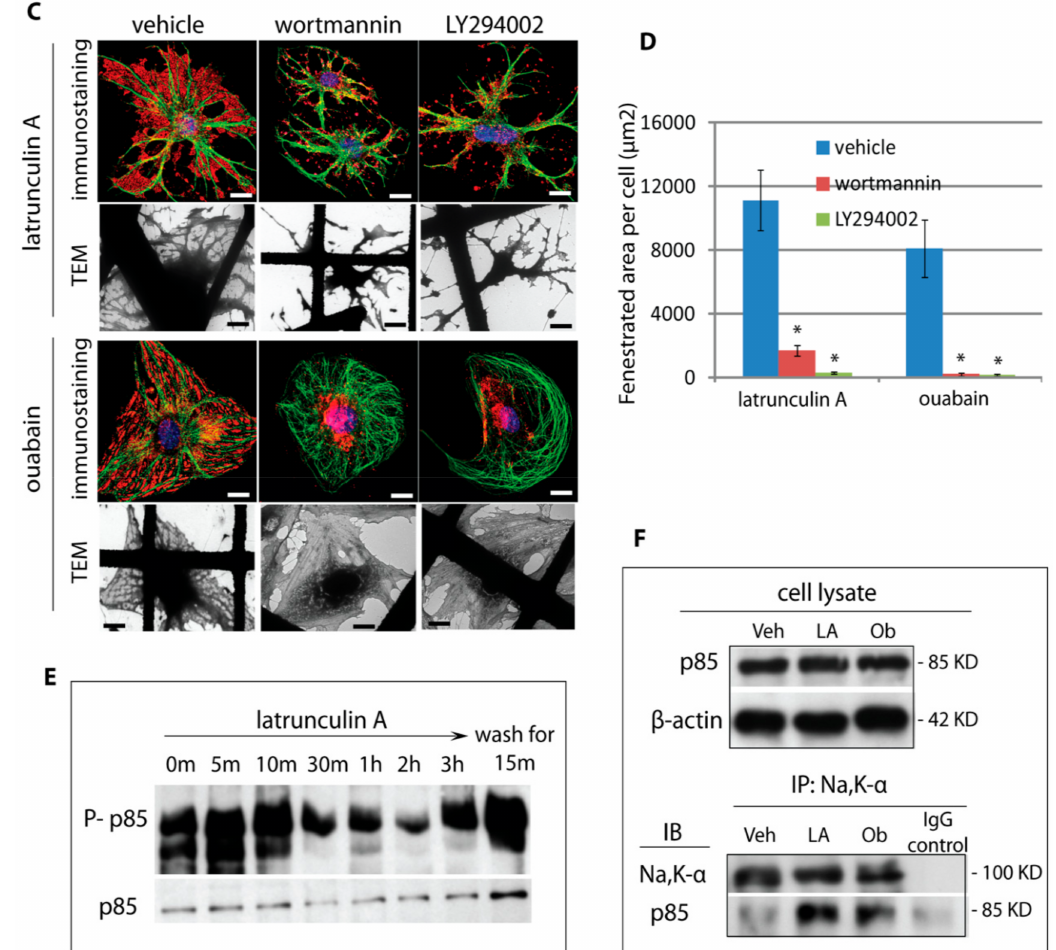
Figure 7. Inhibition of Na,K-ATPase pump function by ouabain induces fenestra formation. ( A ) bEND5 cells were treated with vehicle (PBS) or ouabain at 200 µ M for 24 h. The cells were fixed and immunostained for PV-1 and β -tubulin. Numerous, relatively small sieve plates (arrows) appeared between microtubules (merge panels) in ouabain-treated cells, just as observed in LtA-treated cells. Scale bar, 10 µ m. ( B ) Wholemount TEM analysis confirmed ouabain-induced fenestra formation; right panels show higher magnification view; arrows, fenestral sieve plates. ( C ) Blockade of PI 3-kinase signalling inhibited fenestra formation. Typical microtubule-delineated sieve plates were induced by LtA or ouabain, as shown by immunostaining for PV-1 (red) and β -tubulin (green); DAPI, blue. LtA and ouabain induction of fenestra formation was inhibited by co-incubation with the PI 3-kinase inhibitors, wortmannin (1 µ M), or LY294002 (10 µ M). The reduction of fenestral sieve plates was confirmed by wholemount TEM (lower panels). Arrows, fenestral sieve plates; scale bar, 10 µ m. ( D ) Quantification of fenestrated membrane area from wholemount TEM images showed a near complete inhibition of fenestra formation by wortmannin or LY294002. Error bars represent ± SEM; n ≥ 15; * P < 0.0001. ( E ) PI 3-kinase subunits p85 and p110 α were present in bEND5 cells, and levels were unchanged following fenestra induction. However, phospho-p85 decreases during fenestra induction and is lowest as fenestrae formation peaks. ( F ) Immunoprecipitation with an antibody to Na,K- α demonstrated an increased association of p85 and the sodium pump following induction of fenestrae by LtA or